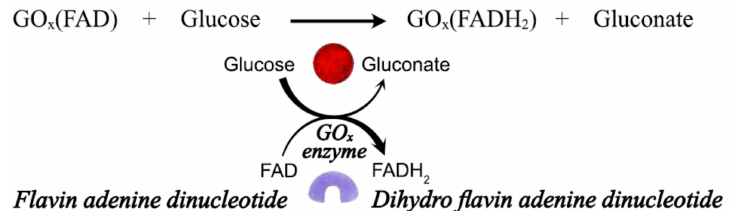
Figure 2. Mechanism for oxidation of glucose by glucose oxidase (GO x ) enzyme.